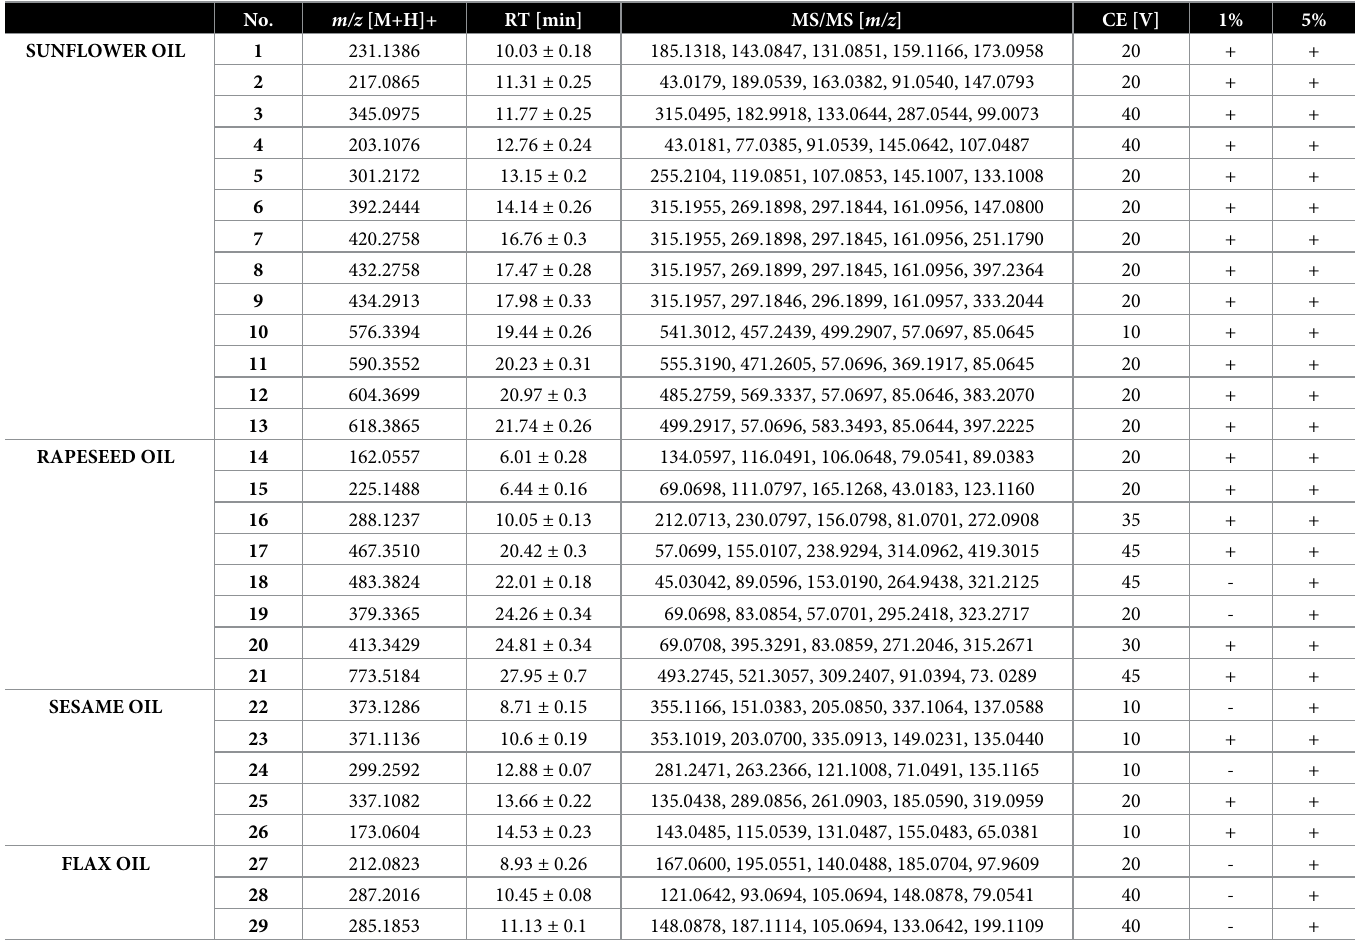
Table 1. Metabolomic oil markers detected by